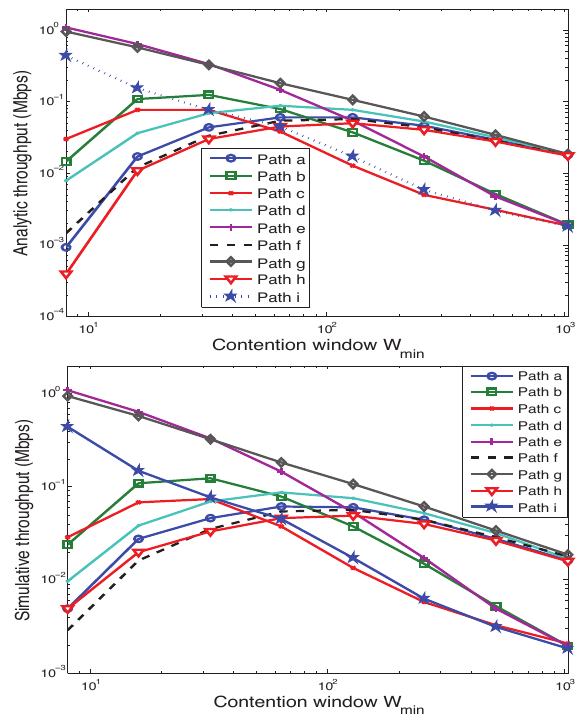
Figure 9. Average end-to-end throughput from model versus simulation when varying the minimum contention